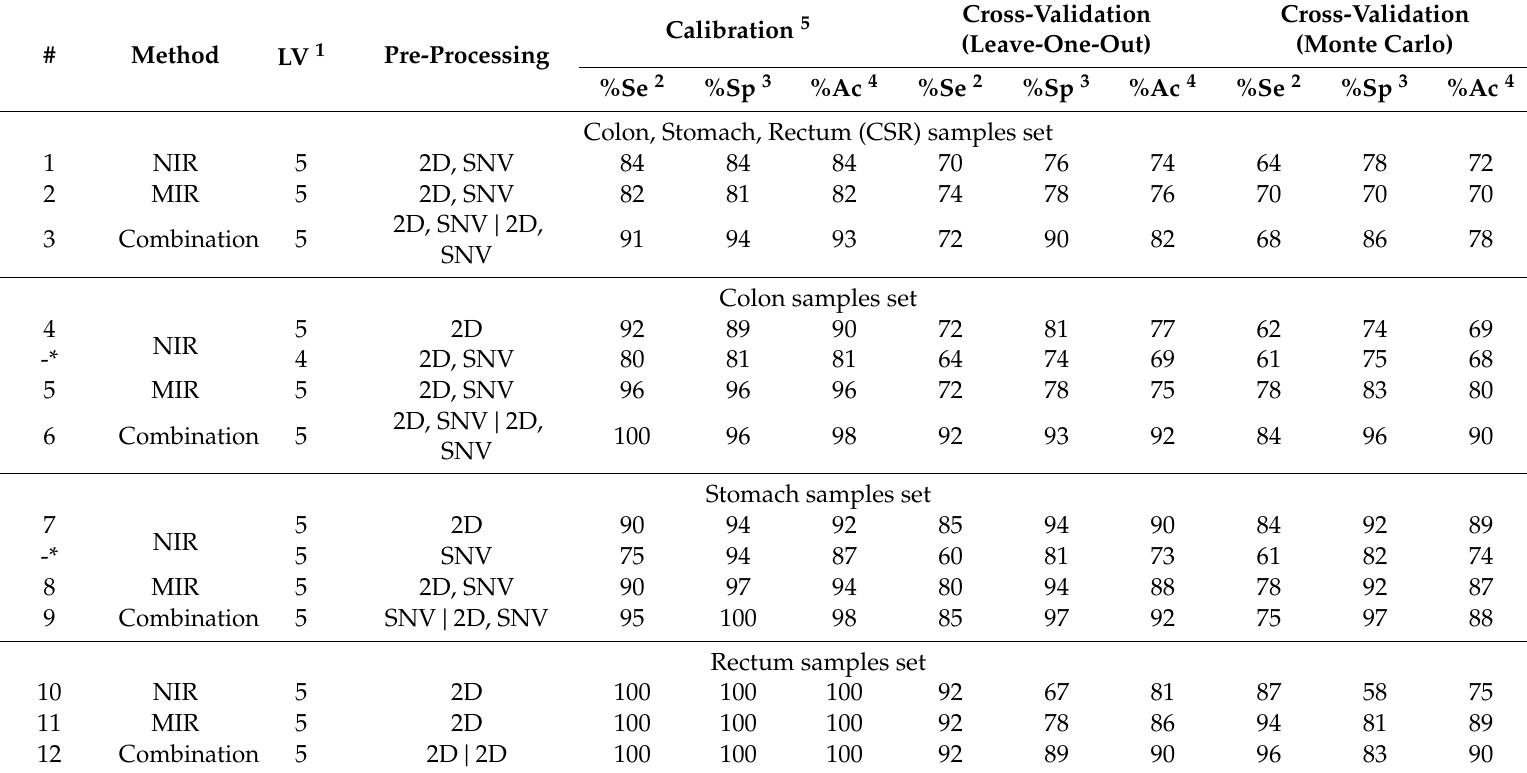
Table 2. Comparison of spectroscopic and data preprocessing methods for cancer